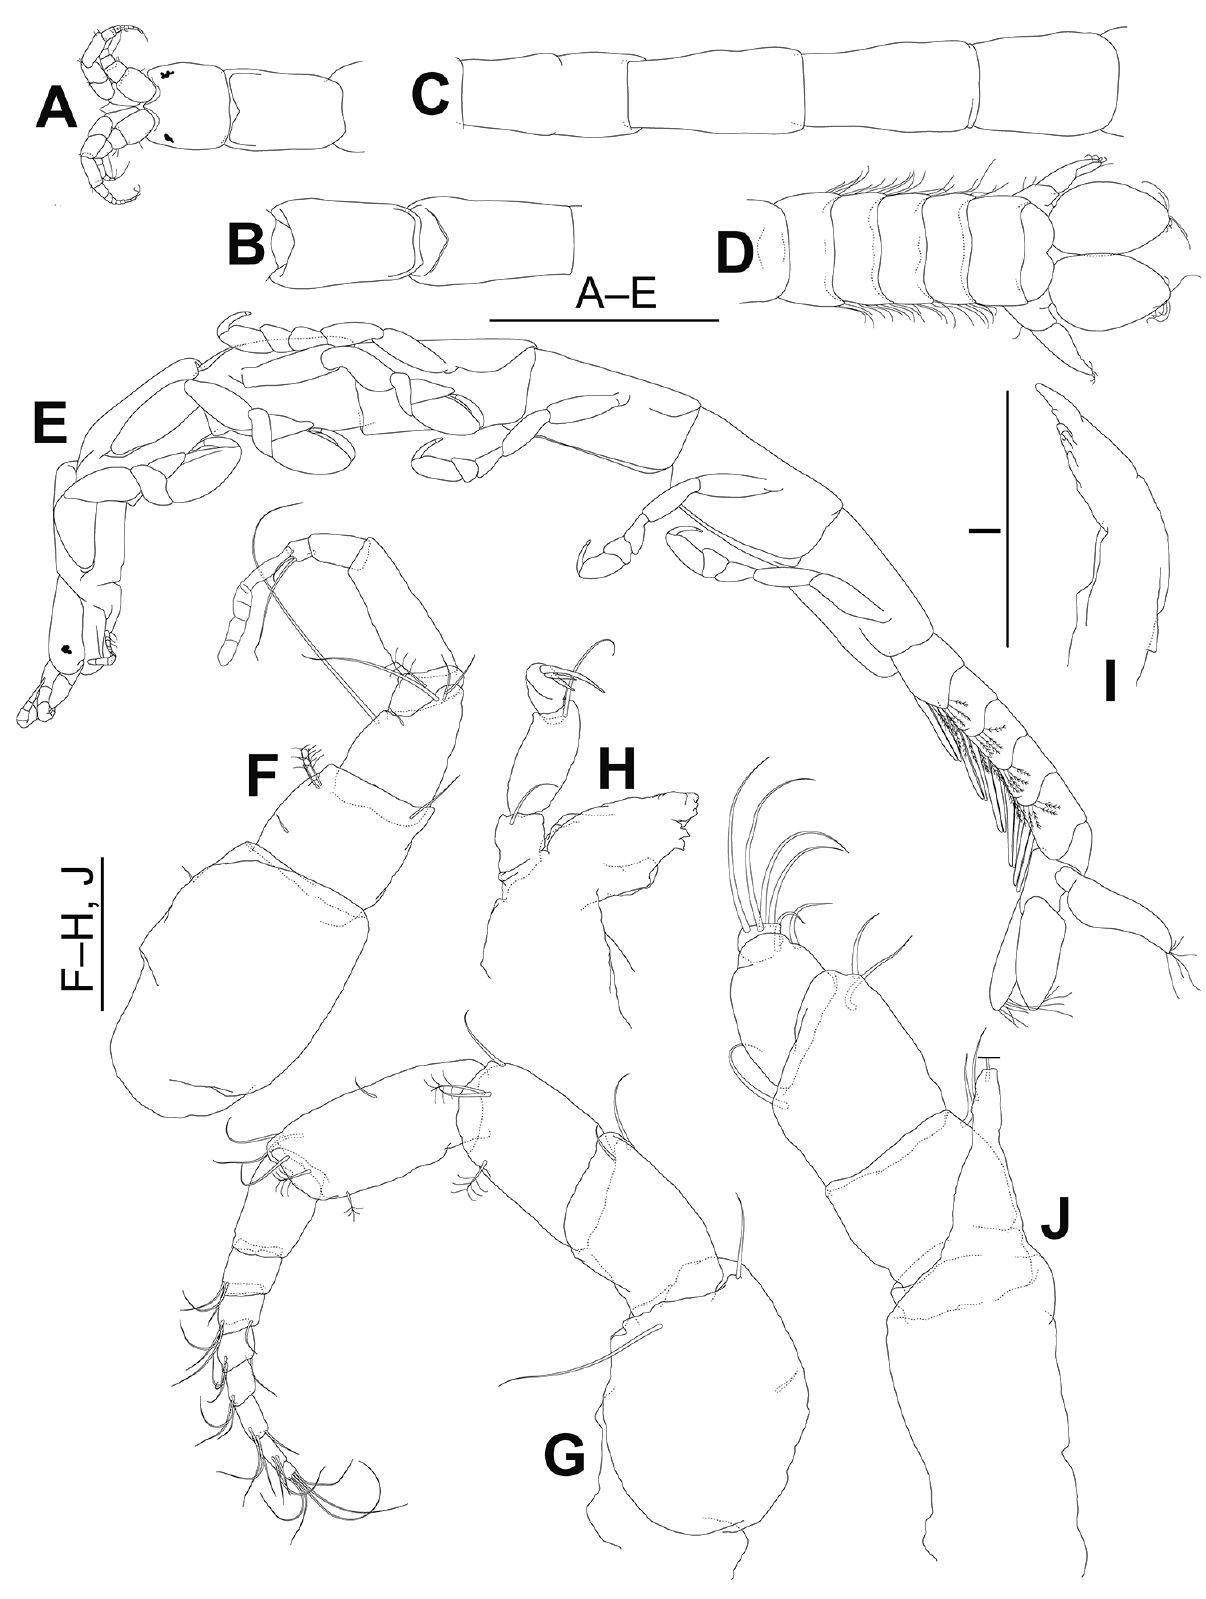
Figure 2. Kupellonura tamago sp. nov., holotype, female. A – D , dorsal view; E , lateral view. A , head and pereonite 1; B , pereonites 2 and 3; C , pereonites 4–7; D , pleon; E , body; F , left antennula; G , right antenna; H , right mandible; I , maxilla; J , left maxilliped. Scale bars: 1 mm ( A–E ); 100 µm ( F–J